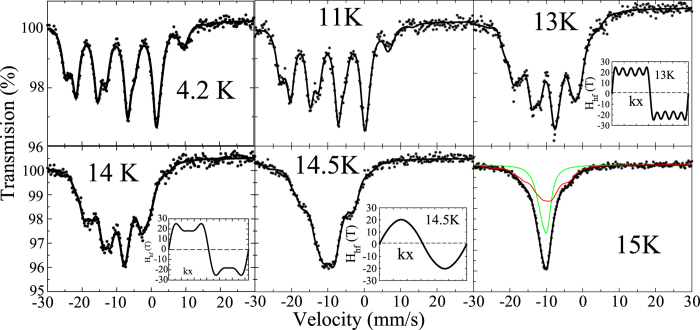
151Eu Mössbauer spectra in EuIrAl4Si2 between 4.2 K and 15 K (see text).The modulations at 13 K, 14 K and 14.5 K along the propagation vector k are shown next to the corresponding spectrum.